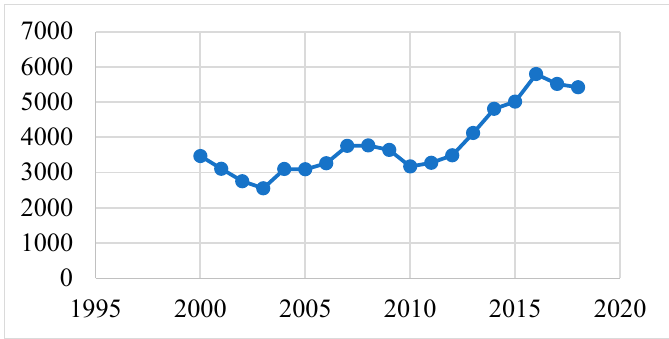
Figure 1. Increment of Domestic Violence Cases (2001–2018). Table 1. Domestic Violence Cases in Malaysia 1 .